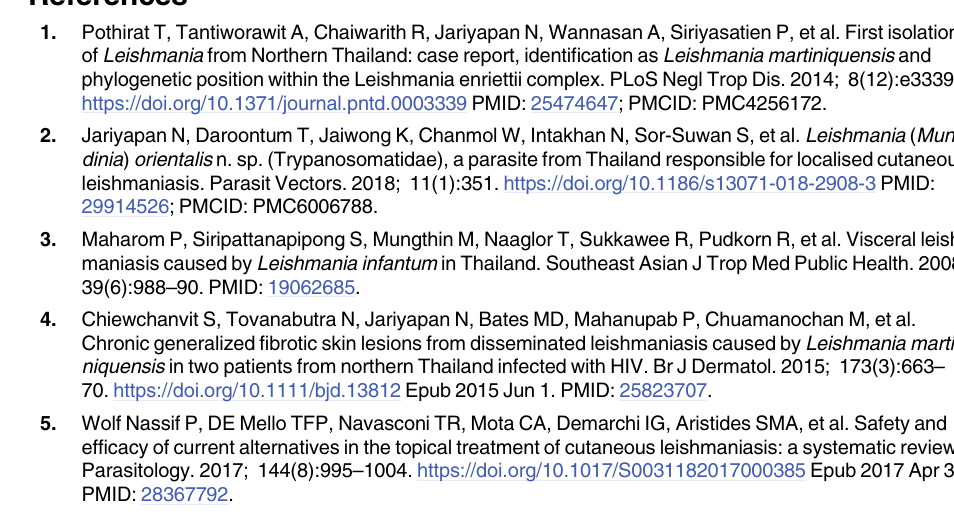
N = Negative control. (TIF) S2 Fig. Multiple sequence alignment of HSP70-I -3 0 -UTR sequences of L . martiniquensis isolates from Thailand and reference strain LEM2494. (TIF) S3 Fig. Multiple sequence alignment of HSP70-I -3 0 -UTR sequences of L . amazonensis (M2269, PH8 and C1S1) and L . mexicana (M379 and U1103) isolates. The positions of the Bsu RI ( Hae III) restriction sites (GGCC) are highlighted.